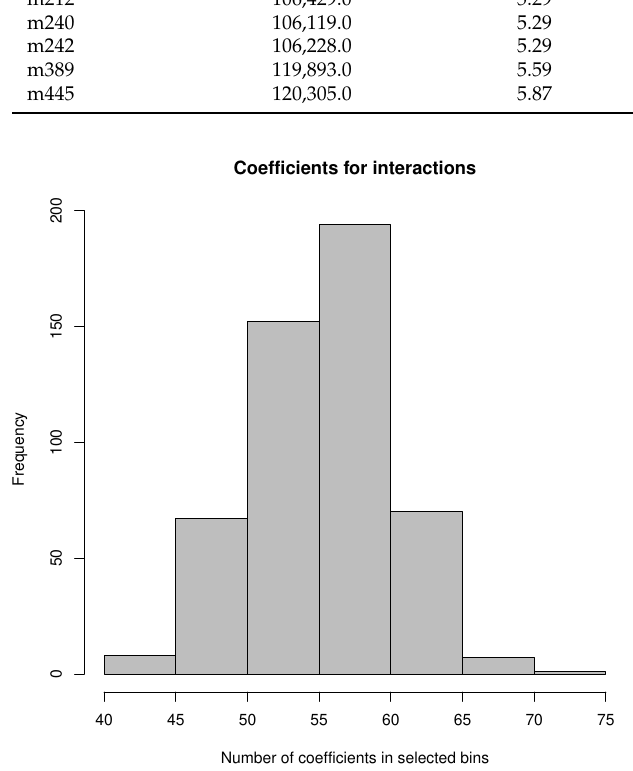
Figure 9. The histogram for number of betas from selected